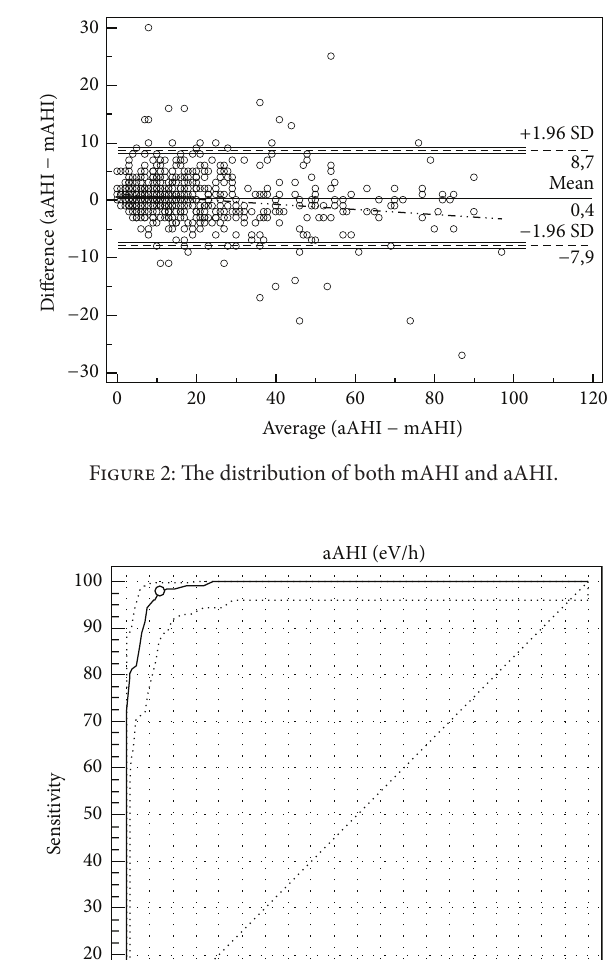
Figure 1: Relationship between mAHI and aAHI.